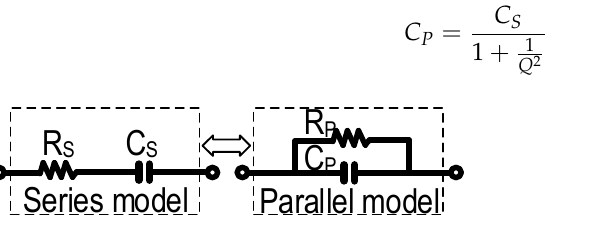
Figure 7. Rectifier’s equivalent impedance model interchangeable from series to parallel.